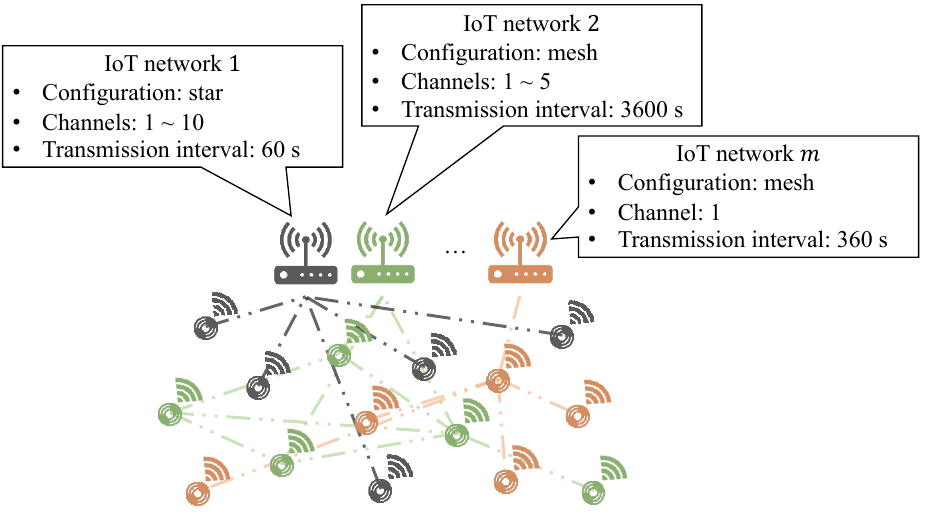
Figure 1. System model of the heterogeneous IoT